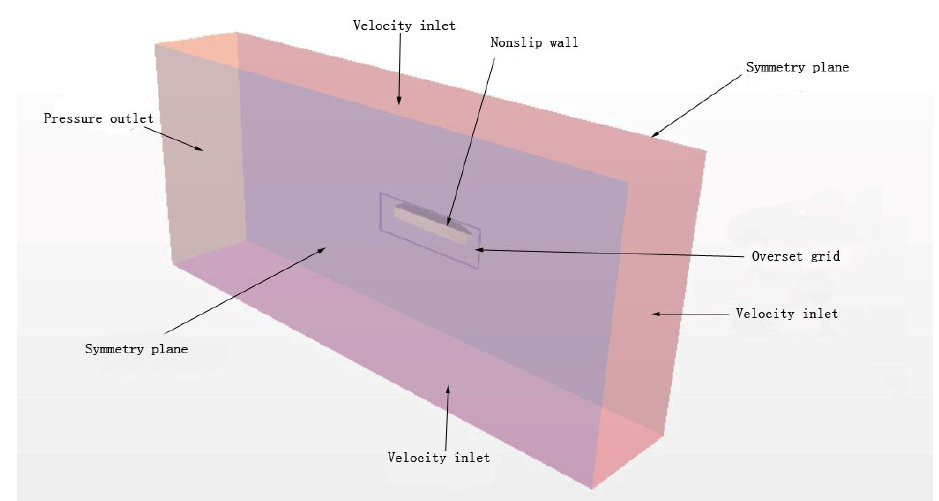
Figure 6. Boundary conditions of the calculation domains.